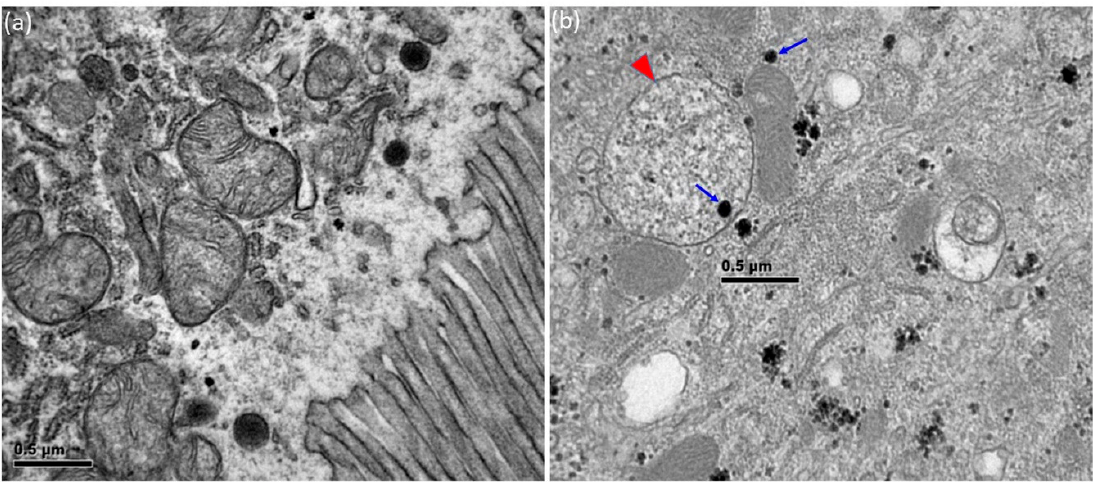
Figure 3. Accumulation of CuONPs in the intestinal epithelial cells. ( a ) CuONPs with the size of 40–50 nm are not detected in the control intestinal epithelial cells; ( b ) CuONPs (arrows) are detected inside the cytoplasm of CuONP-exposed epithelia cells. Note that some of CuONPs are observed inside the vesicle (arrowhead).